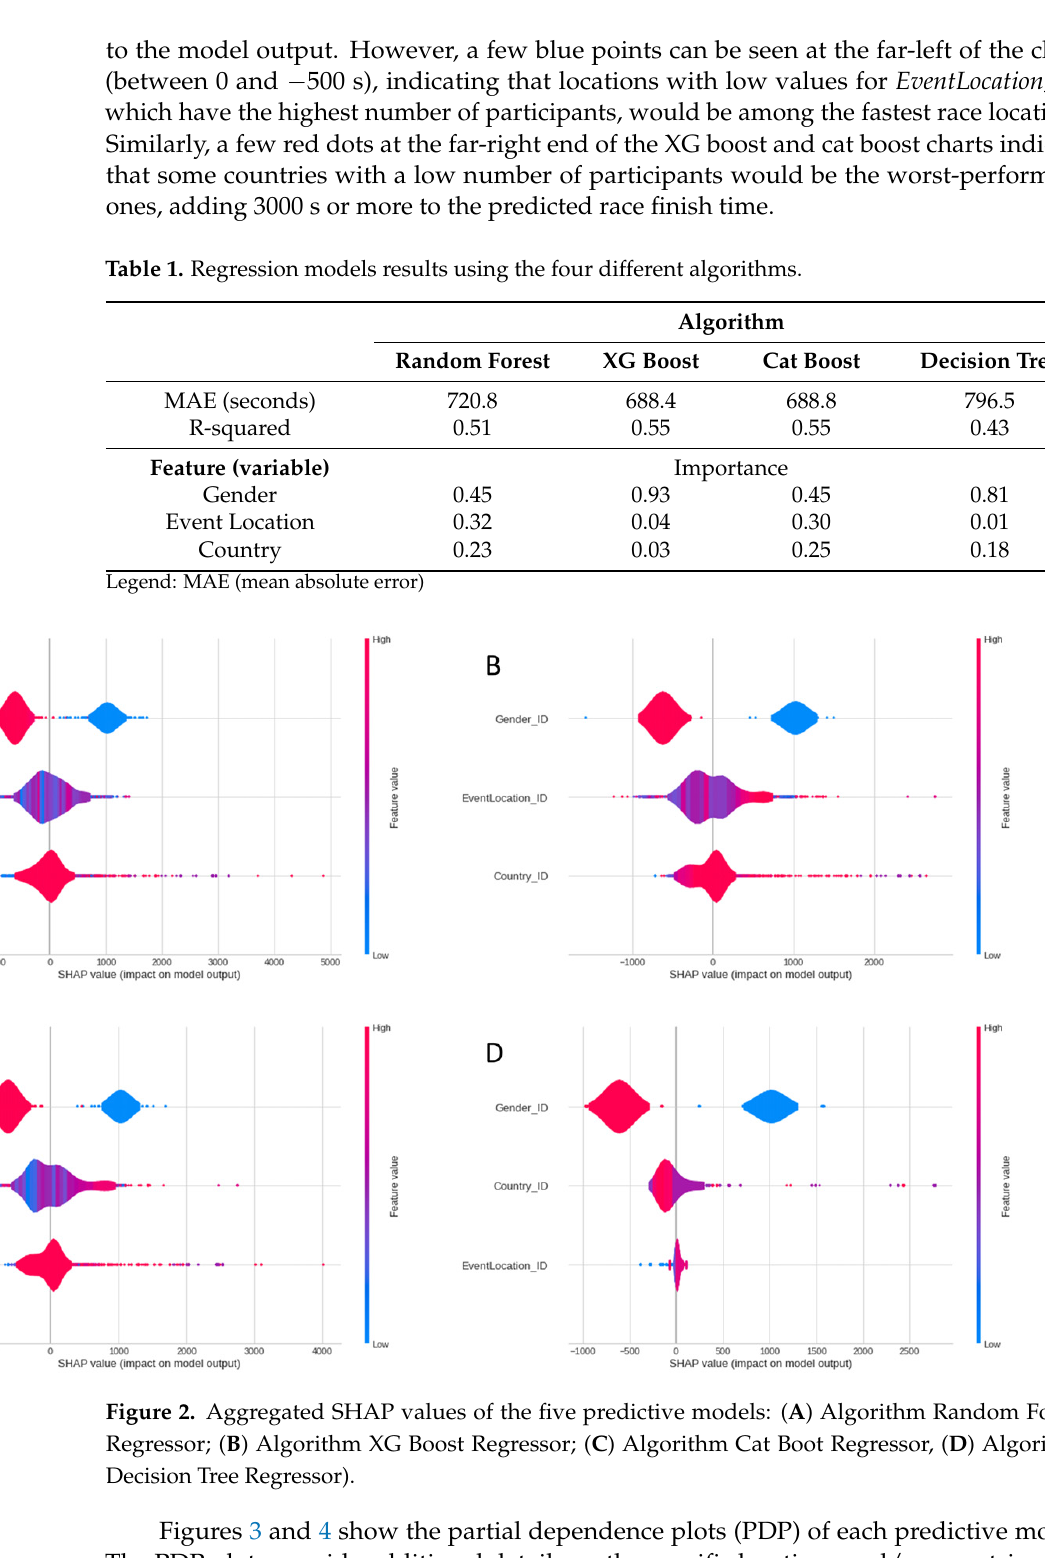
Regressor; ( B ) Algorithm XG Boost Regressor; ( C ) Algorithm Cat Boot Regressor, ( D ) Algorithm Decision Tree Regressor).